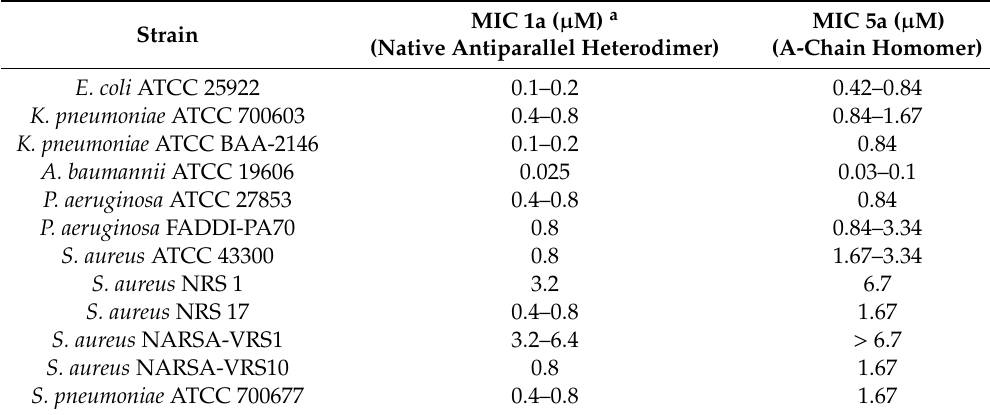
Table 1. Minimum inhibitory concentrations of 5a (A-chain homomer) and 1a (native antiparallel heterodimer) against Gram-negative and Gram-positive bacteria from the genera Escherichia , Klebsiella , Acinetobacter , Pseudomonas , and Staphylococcus